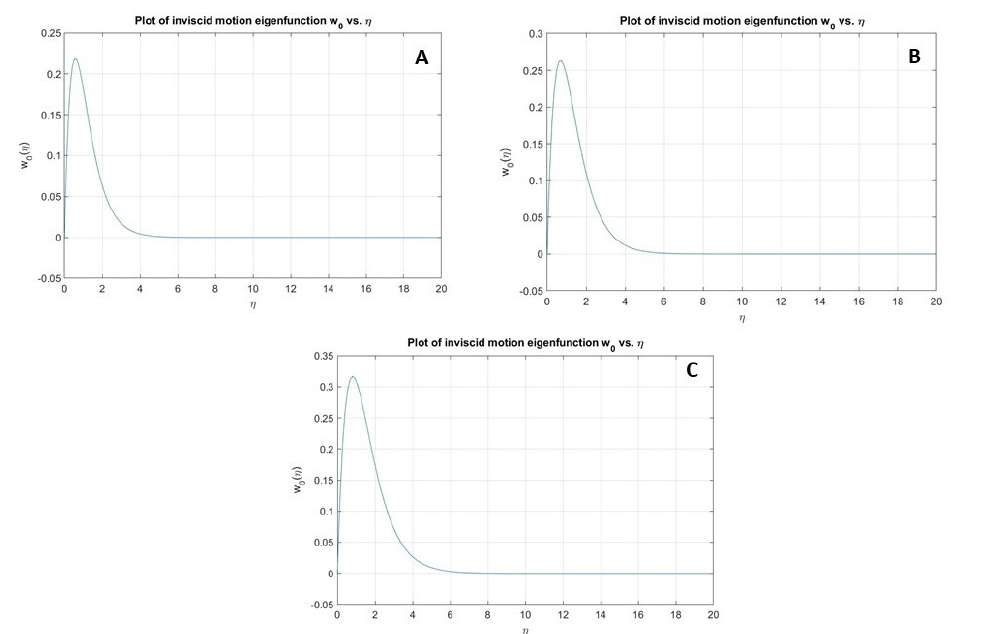
Figure 10. Plot showing the inviscid motion eigenfunction w 0 against η for ψ = 90, T s = 0.05 with W ∗ = − 0.35 ( A ), 0 ( B ) and 0.35 ( C